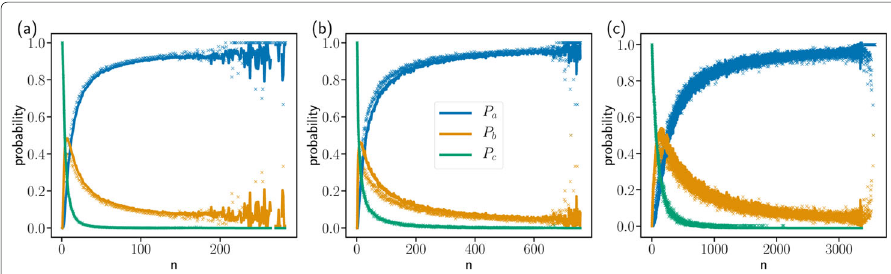
Fig. 3 The relative probabilities of insertion types a , b and c (dots) together with the results of Eq. 8 (lines). a on a ring network with N = 101, b on a square 10 × 10 grid, c on a star graph with N =